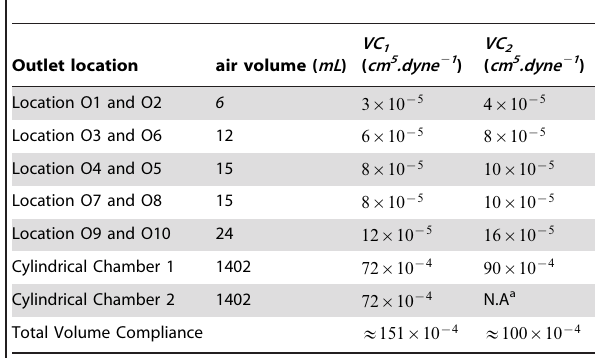
Table 3. Volume compliance by air column.